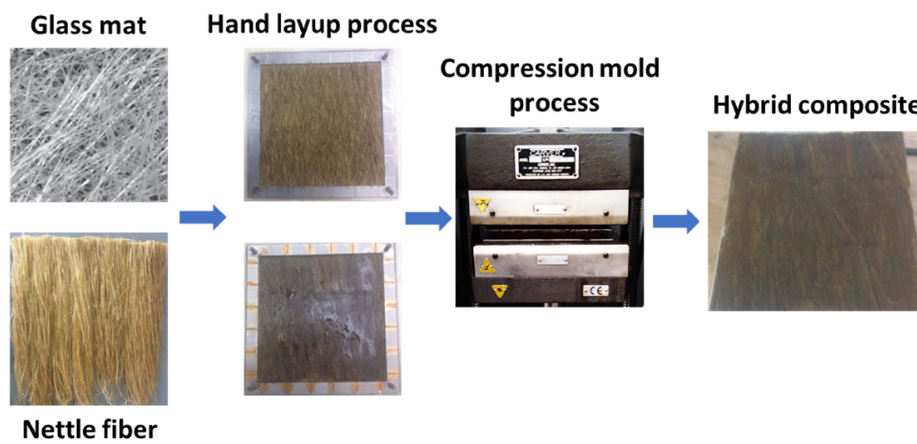
Figure 1. Hybrid composite manufacturing